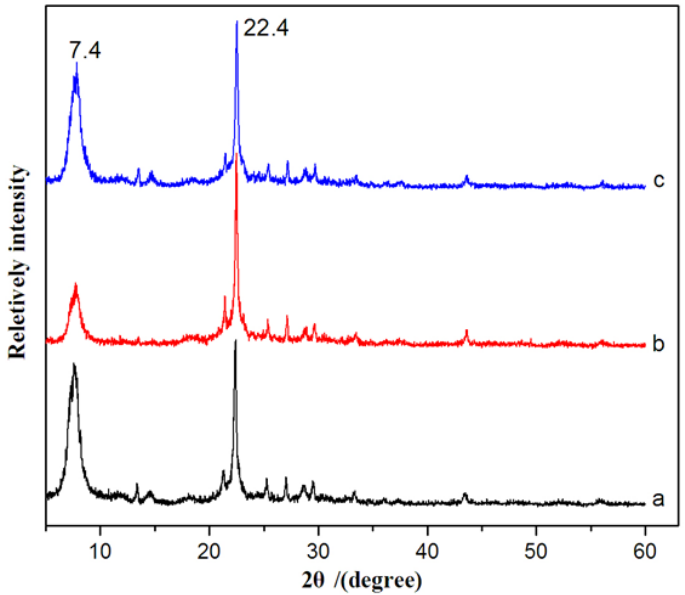
Figure 2. XRD patterns of ( a ) HBEA-25 ( b ) recovered HBEA-25 ( c ) regenerated HBEA-25.